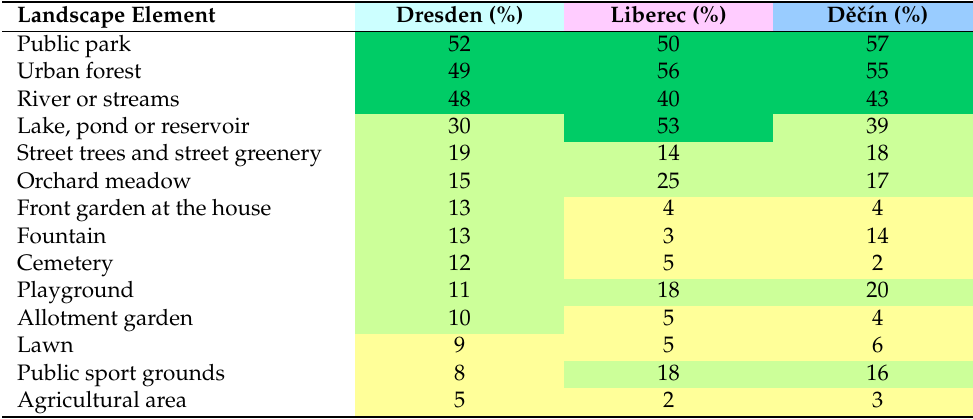
Table 6. Landscape elements and their appreciation (The colours relate to the three appreciation levels in Figure